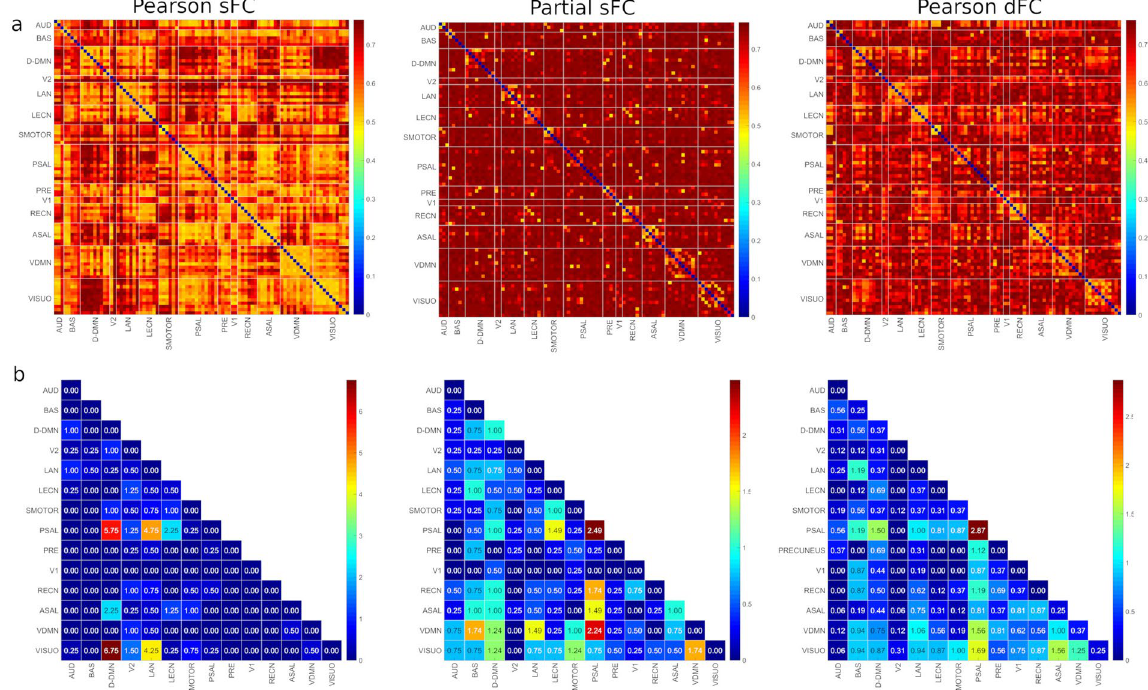
Figure 3. ( a ) Differential power of edges using Pearson sFC, partial sFC and Pearson dFC methods. The color bar to the right of each figure displays the mapping of edge differential power values to the color map. ( b ) Edge contribution percentages in subject identification at 95 percentile threshold. The color bar to the right of each figure displays the mapping of edge contribution percentage values to the color map. AUD-Auditory, BAS-Basal Ganglia, DDMN-Dorsal Default Mode Network, V2-Primary Visual, LAN-Language, LECN-Left Executive Control Network, SMOTOR-Sensorimotor, PSAL-Posterior Salience, PRE-Precuneus, V1-High Visual, RECN- Right Executive Control Network, ASAL-Anterior Salience, VDMN-Ventral Default Mode Network, VISUO- Visuospatial.